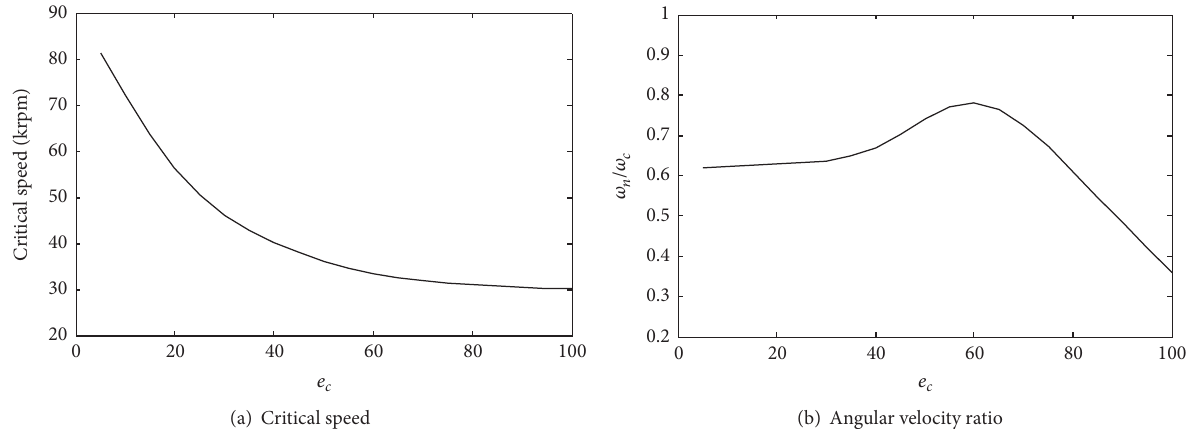
Figure 8: Theoretical influence of the radial displacement of the rotor center on the system stability.